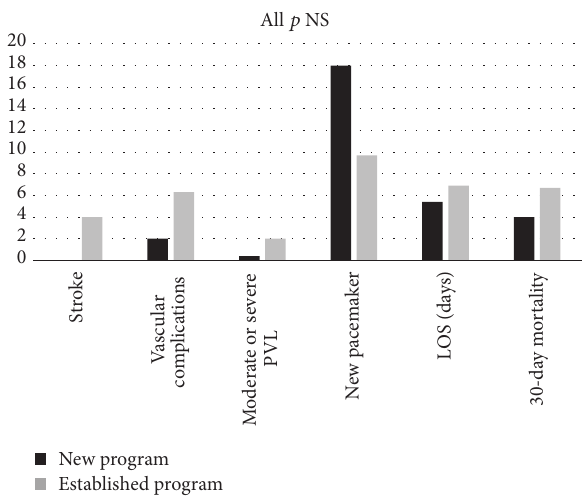
Figure 2: Procedural complications, length of stay, and in-hospital